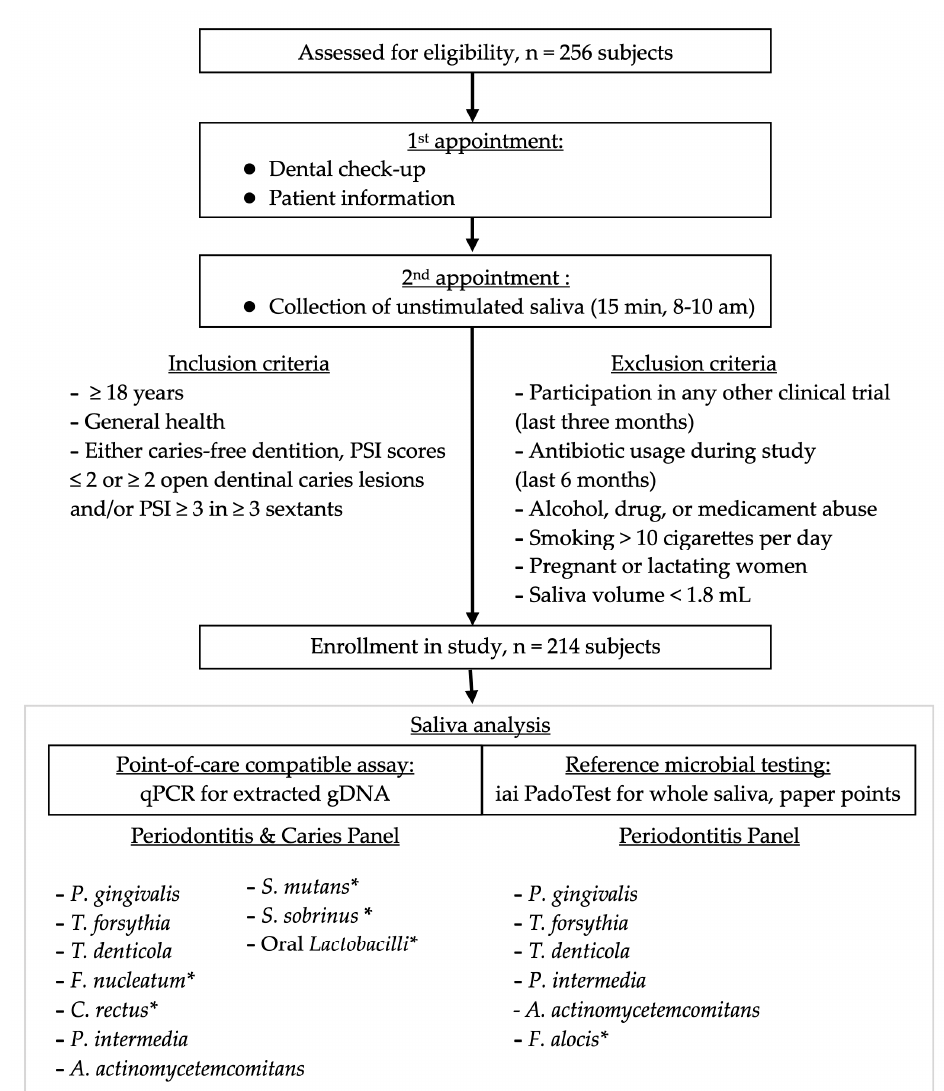
Figure 1. Flow-chart of the study, illustrating recruitment, study population, saliva sampling and saliva analysis. * Differences in bacterial species between the two analysis methods.